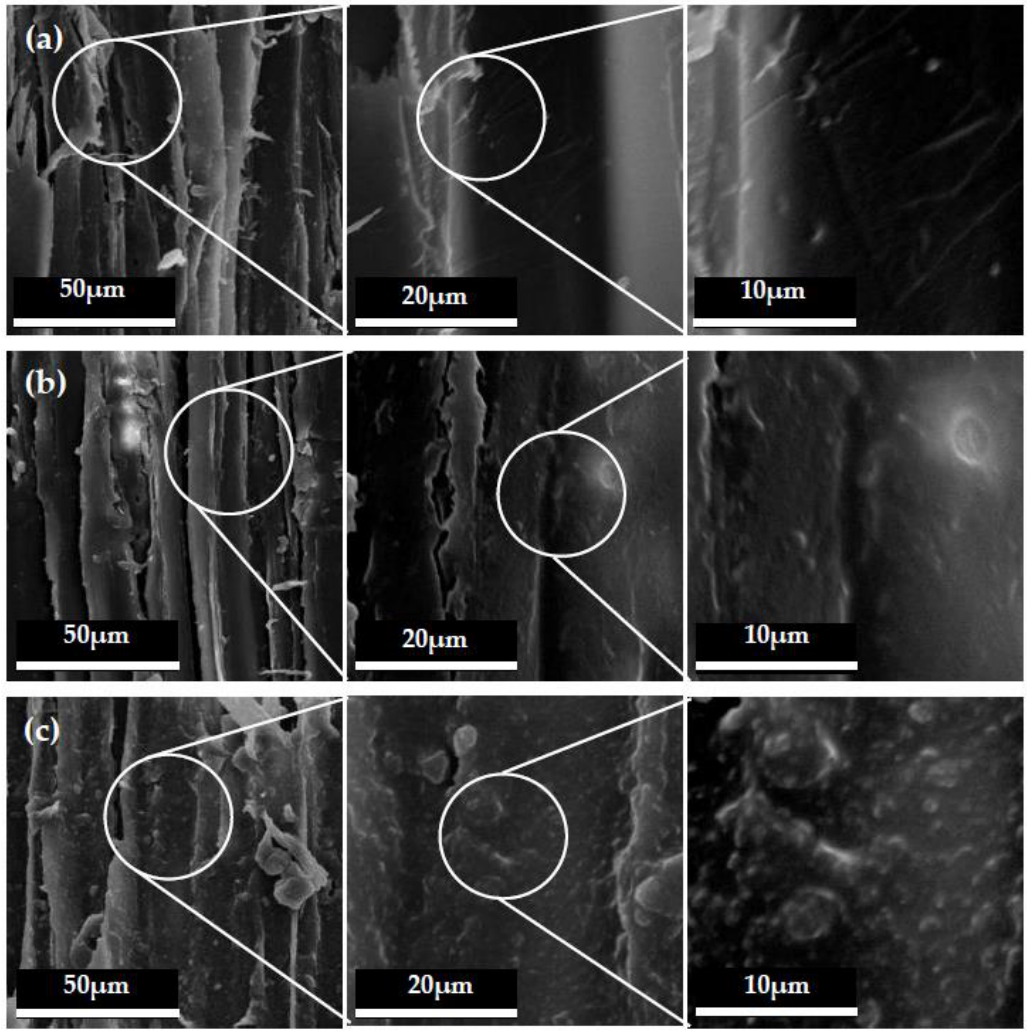
Figure 4. SEM morphology of wood tangential section: ( a ) untreated wood, ( b ) with PDMS resin layer, ( c ) the hydrophobic surface with nano and micro hollow mesoporous microspheres.